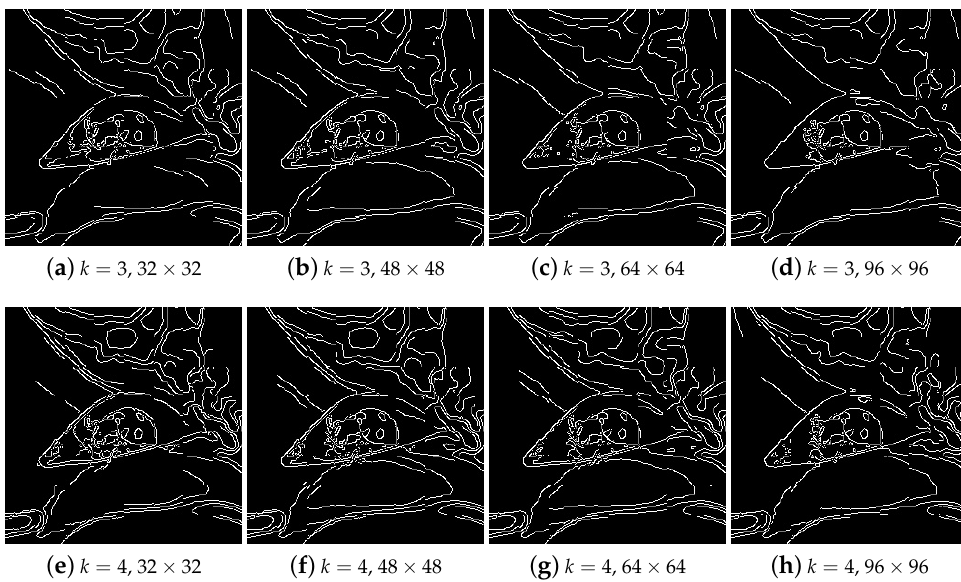
Figure 8. Edges detected by the local k-Means algorithm with a different number of segments (rows: k = 3, k = 4) and different sizes of the mask (columns: 32 × 32, 48 × 48, 64 × 64, and 96 × 96